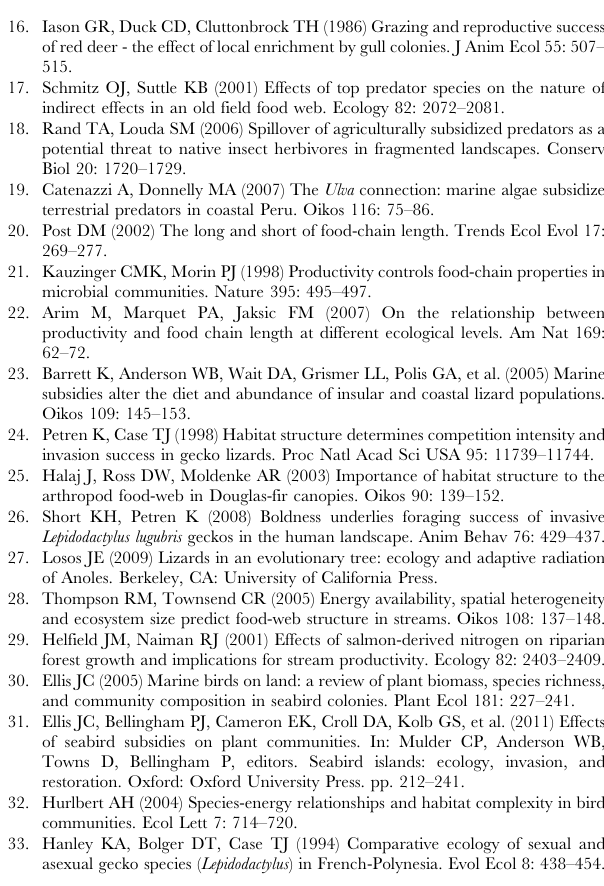
Table S1 Isotopic value of prey and R. rattus (mean 6 SD) by forest type and